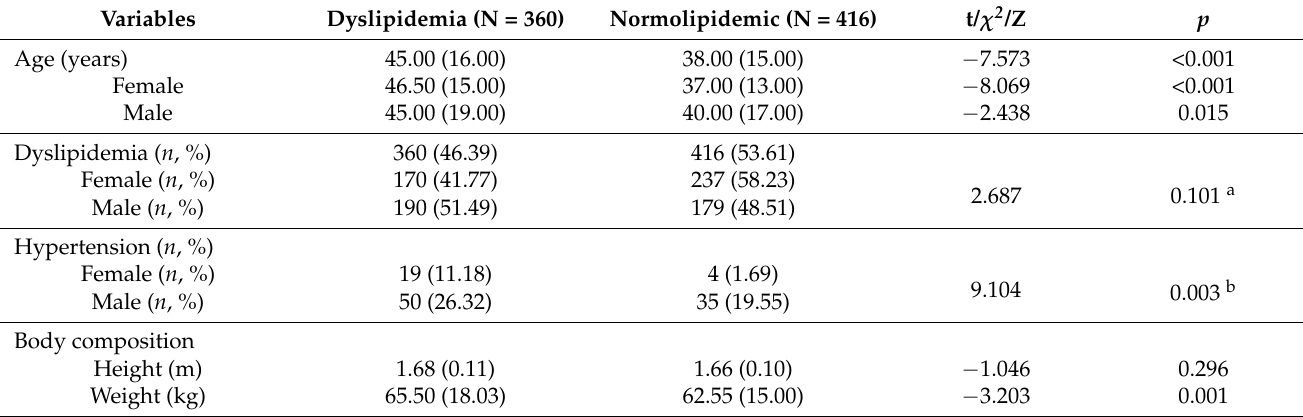
Table 2. Basic characteristic of the study